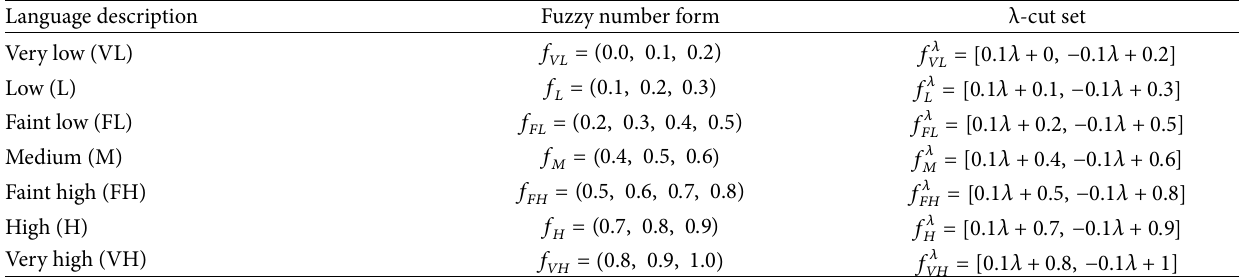
Table 2: Fuzzy Number Form and -cut Set [64]. 𝜆